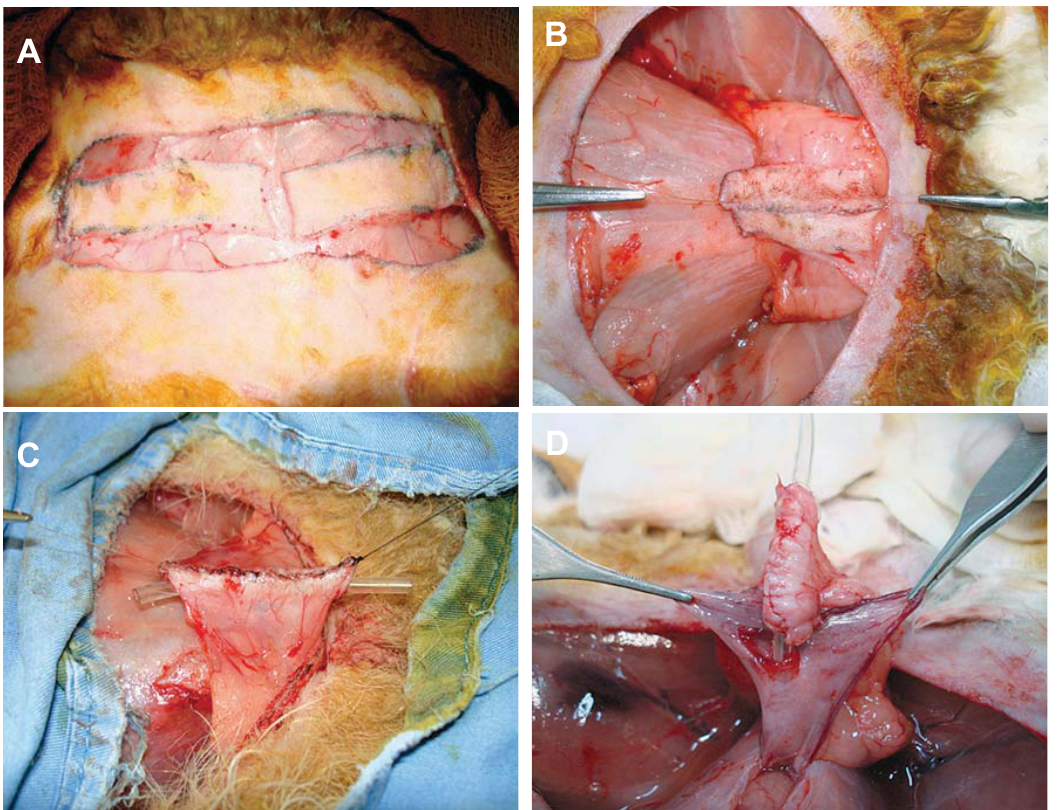
Figure 1 – (cid:3)(cid:55)(cid:90)(cid:82)(cid:3)(cid:85)(cid:72)(cid:70)(cid:87)(cid:68)(cid:81)(cid:74)(cid:88)(cid:79)(cid:68)(cid:85)(cid:3)(cid:86)(cid:78)(cid:76)(cid:81)(cid:3)(cid:192)(cid:68)(cid:83)(cid:86)(cid:3)(cid:20)(cid:91)(cid:23)(cid:3)(cid:70)(cid:80)(cid:3)(cid:82)(cid:83)(cid:83)(cid:82)(cid:86)(cid:76)(cid:87)(cid:72)(cid:3)(cid:72)(cid:68)(cid:70)(cid:75)(cid:3)(cid:82)(cid:87)(cid:75)(cid:72)(cid:85)(cid:3)(cid:76)(cid:81)(cid:3)(cid:87)(cid:75)(cid:72)(cid:3)(cid:80)(cid:76)(cid:71)(cid:71)(cid:79)(cid:72)(cid:3)(cid:79)(cid:76)(cid:81)(cid:72)(cid:3)(cid:82)(cid:73)(cid:3)(cid:87)(cid:75)(cid:72)(cid:3)(cid:79)(cid:82)(cid:90)(cid:72)(cid:85)(cid:3)(cid:76)(cid:81)(cid:73)(cid:72)(cid:85)(cid:76)(cid:82)(cid:85)(cid:3)(cid:68)(cid:69)(cid:71)(cid:82)(cid:80)(cid:72)(cid:81)(cid:3)(cid:68)(cid:85)(cid:72)(cid:3)(cid:68)(cid:81)(cid:68)(cid:86)(cid:87)(cid:82)(cid:80)(cid:82)(cid:86)(cid:72)(cid:71)(cid:3)(cid:68)(cid:86)(cid:3) an “onlay” to create a tube to be connected to the bladder